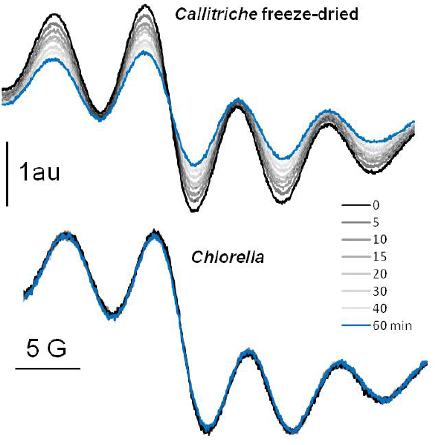
Figure 4. Representative subsequent EPR spectra of DPPH • signal during the time of experiment. G [Gauss] – magnetic field strength